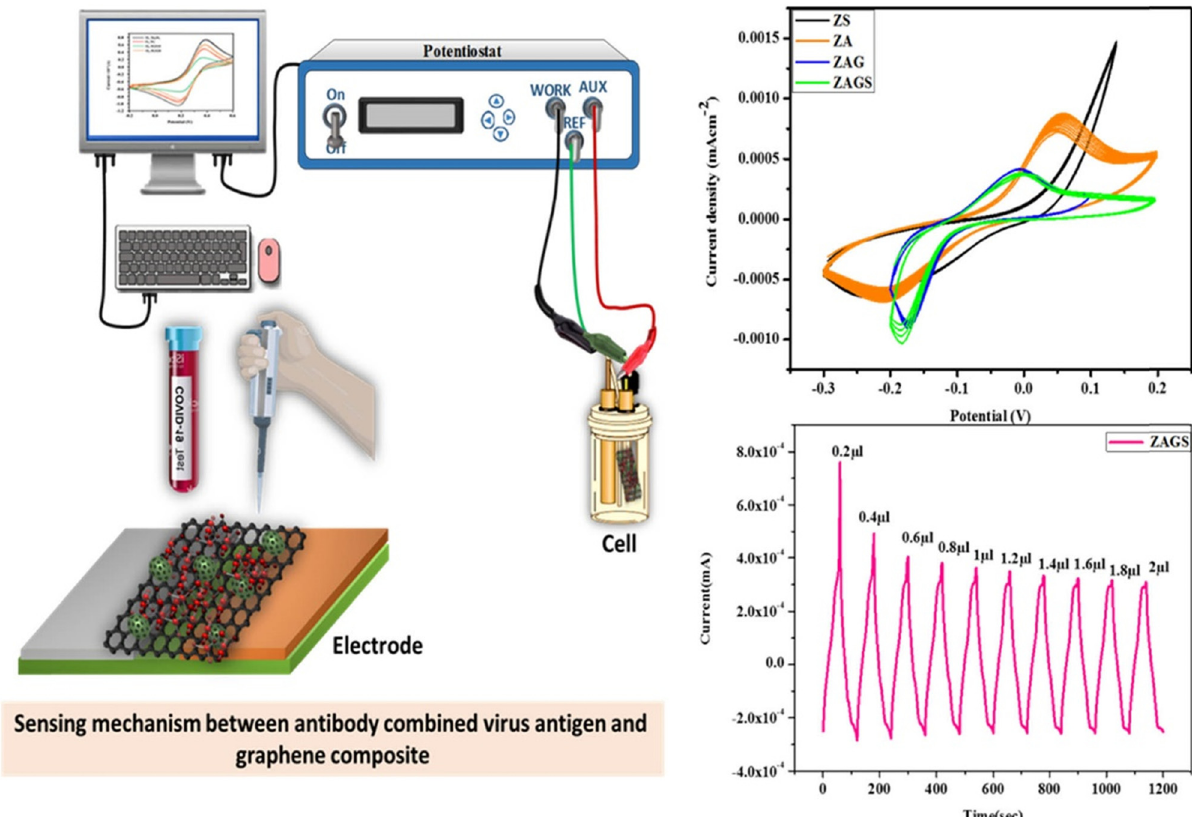
Figure 9: Graphene quaternary nanocomposite - based sensor and C – V – I – V curve [ 88 ]